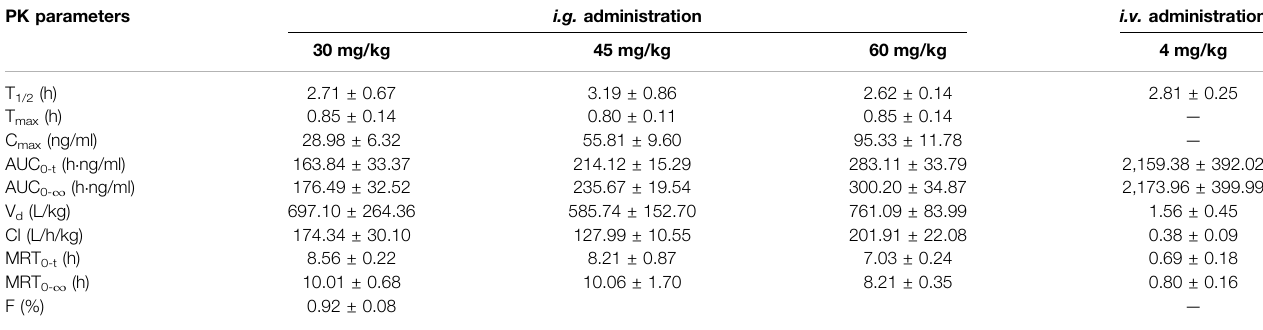
TABLE 4 | Non-compartmental pharmacokinetic parameters of DF after single i.g. and i.v. administration in rats (Mean ± SD, n (cid:1) 6). PK parameters